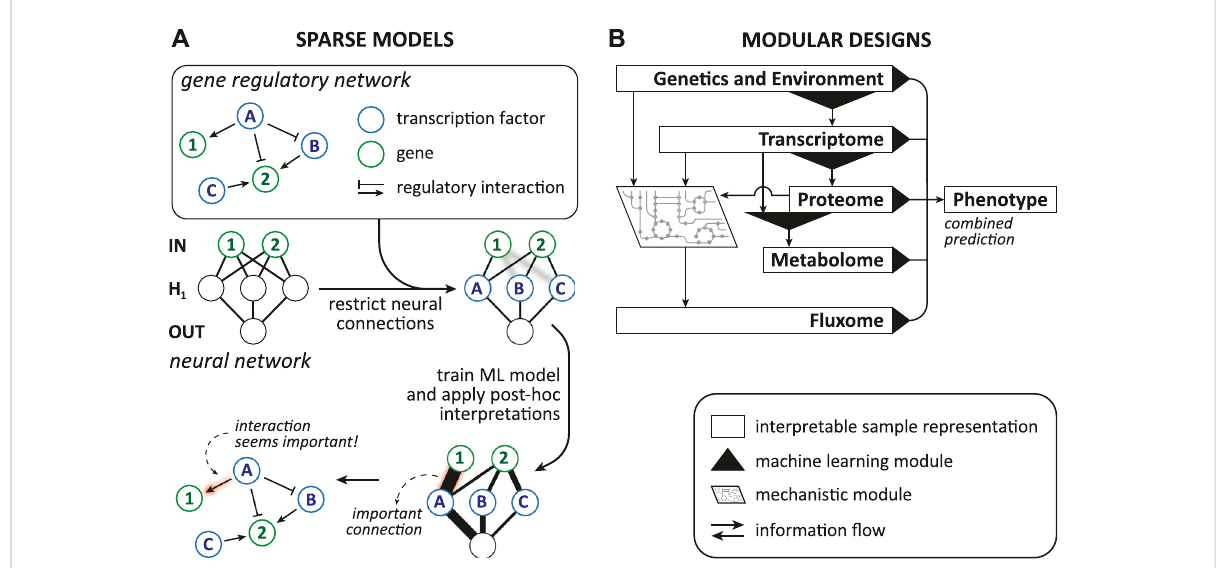
FIGURE 6 Examples of model-based interpretation methods from Section 4.4 in simpli fi ed form. (A) Guiding the topology of a neural network by a biological network can increase interpretability. This example captures the fundamental principle of the model-based interpretation strategy presented by Nguyen et al. (2021) and further by Wang et al. (2021). By assigning each neuron in the fi rst hidden layer, H 1 , to a biological entity (i.e., a transcription factor in this example), connections to biologically meaningful inputs (i.e., genes) can be wired according to a biological network. This limits the possible connections in the neural network, introducing sparsity. After training, post-hoc techniques could measure the importance ( red glow ) of the interpretable connections, revealing potentially relevant biological interactions. (B) Simpli fi ed version of the modular design described by Kim et al. (2016) for predicting the growth phenotype, metabolic dynamics, and expression levels of a cell from its genetics and environment. In general, a modular design may describe a sample or aspects of it in different biologically meaningful ways (i.e., interpretable sample representations). Modules then convert between these transparent representations and may rely on machine learning or mechanistic principles. In the portrayed example (Kim et al., 2016), ML modules connect the genetic and environmental inputs and different omics representations. A mechanistic module (i.e., a metabolic model) is embedded into the design and infers the fl uxome under constraints derived from multiple representations. Finally, predictions from multiple ML modules are combined to estimate the